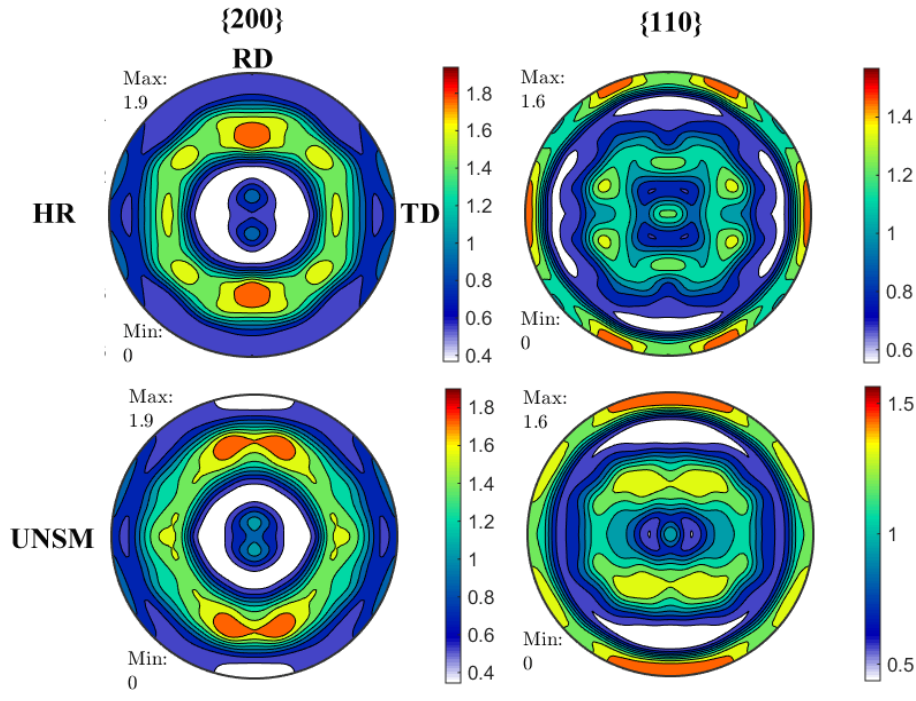
Figure 6. {200} and {110} pole figures of LA106 Mg-Li alloy before and after the UNSM treatment.